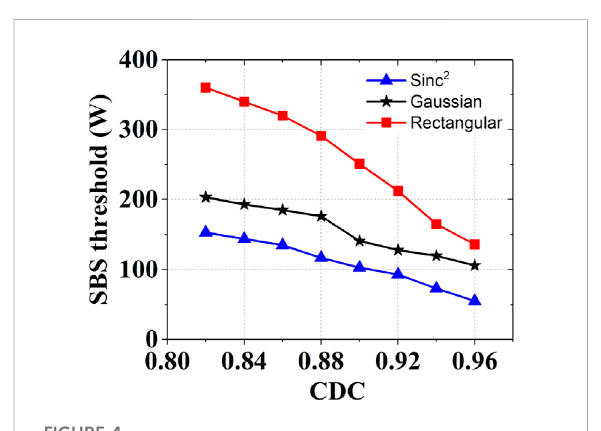
FIGURE 4 ThedependenceofSBSthresholdonthespectralCDCunder 0.1 ns delay